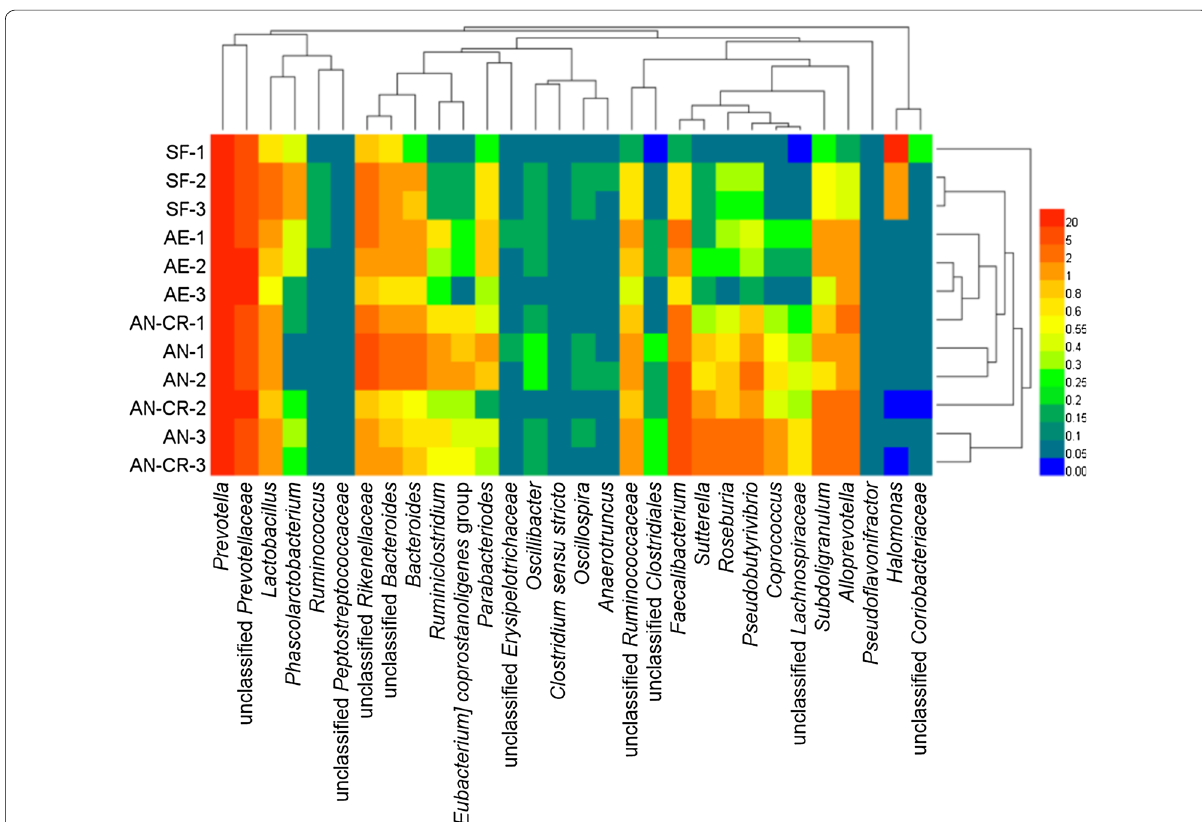
Fig. 5 Heat map of genera in the relative abundances of active bacterial communities in all groups. SF sows’ fecal group, AE aerobic group, AN anaerobic group, AE-CR anaerobic-cryopreserved